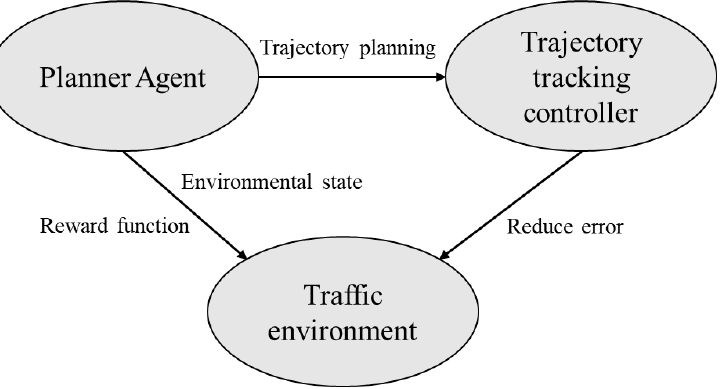
Figure 10. Planner/Controller/Environment relationship diagram.